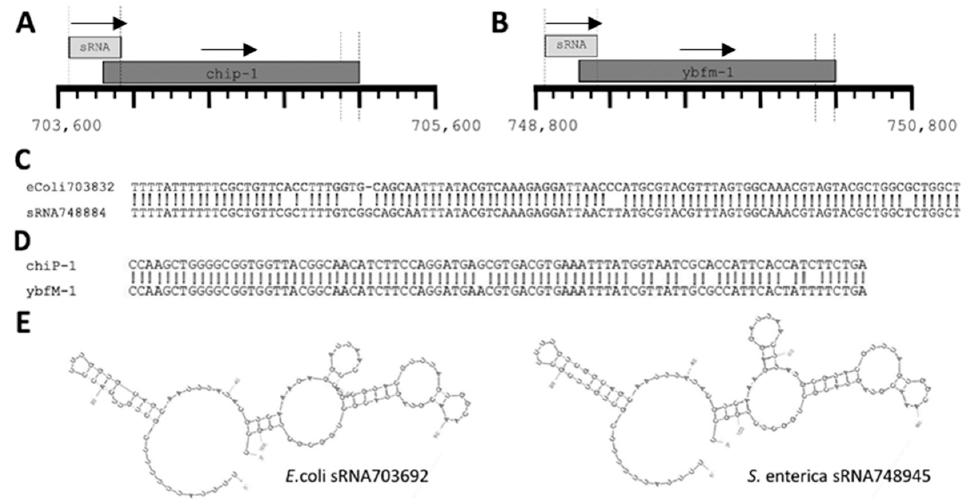
Figure 5. E. coli sRNA703832 and Salmonella sRNA748884 sequence comparison. ( A ) Cartoon illustrating genomic position of sRNA703692 and overlapping protein coding gene in Escherichia coli. ( B ) Cartoon illustrating genomic position of sRNA748945 and overlapping protein coding gene in Salmonella enterica SL1344. ( C ) ClustalW alignment of E. coli sRNA703692 and S. enterica sRNA748945 genomic loci as demarcated by vertical lines in A and B. ( D ) ClustalW alignment of 3’ ends of E. coli chip-1 and S. enterica ybfm-1 genomic loci as demarcated by vertical lines in A and B. ( E ) Predicted secondary structures [21] of E.coli sRNA703692 ( left ) and S. enterica sRNA748945 ( right ). Transcriptional direction is in- dicated by an arrow just above a sRNA / gene name.